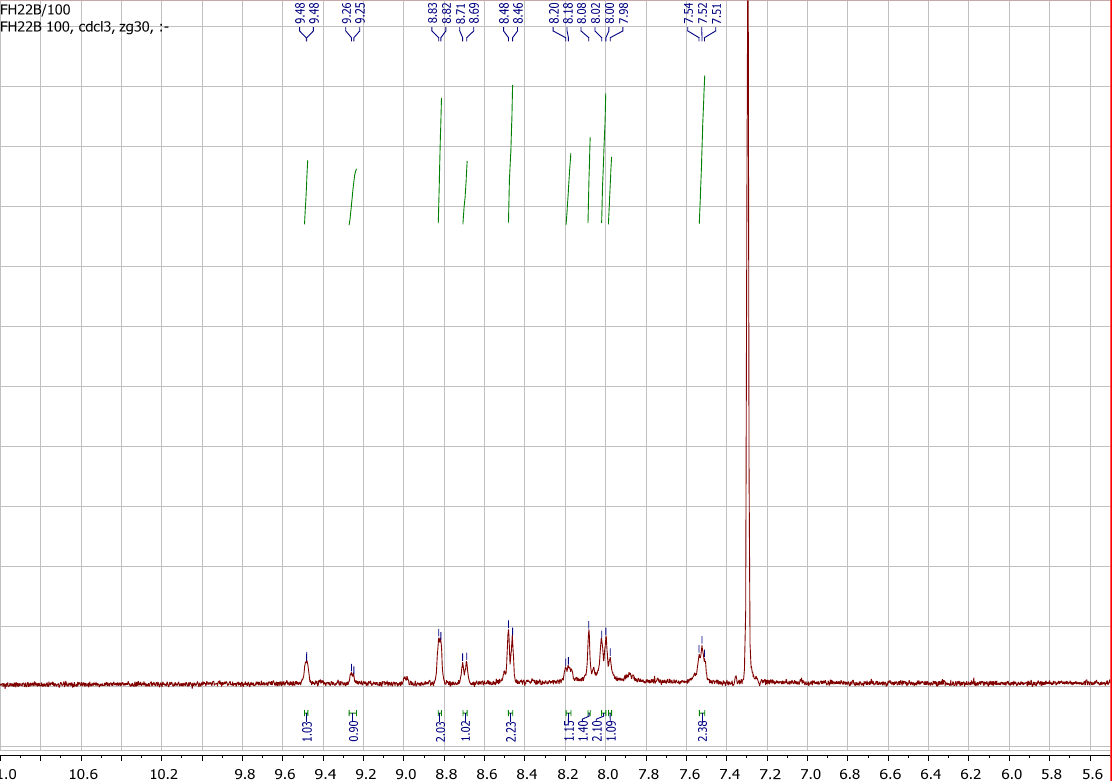
L (NCS) ] in CDCl 1 2 2